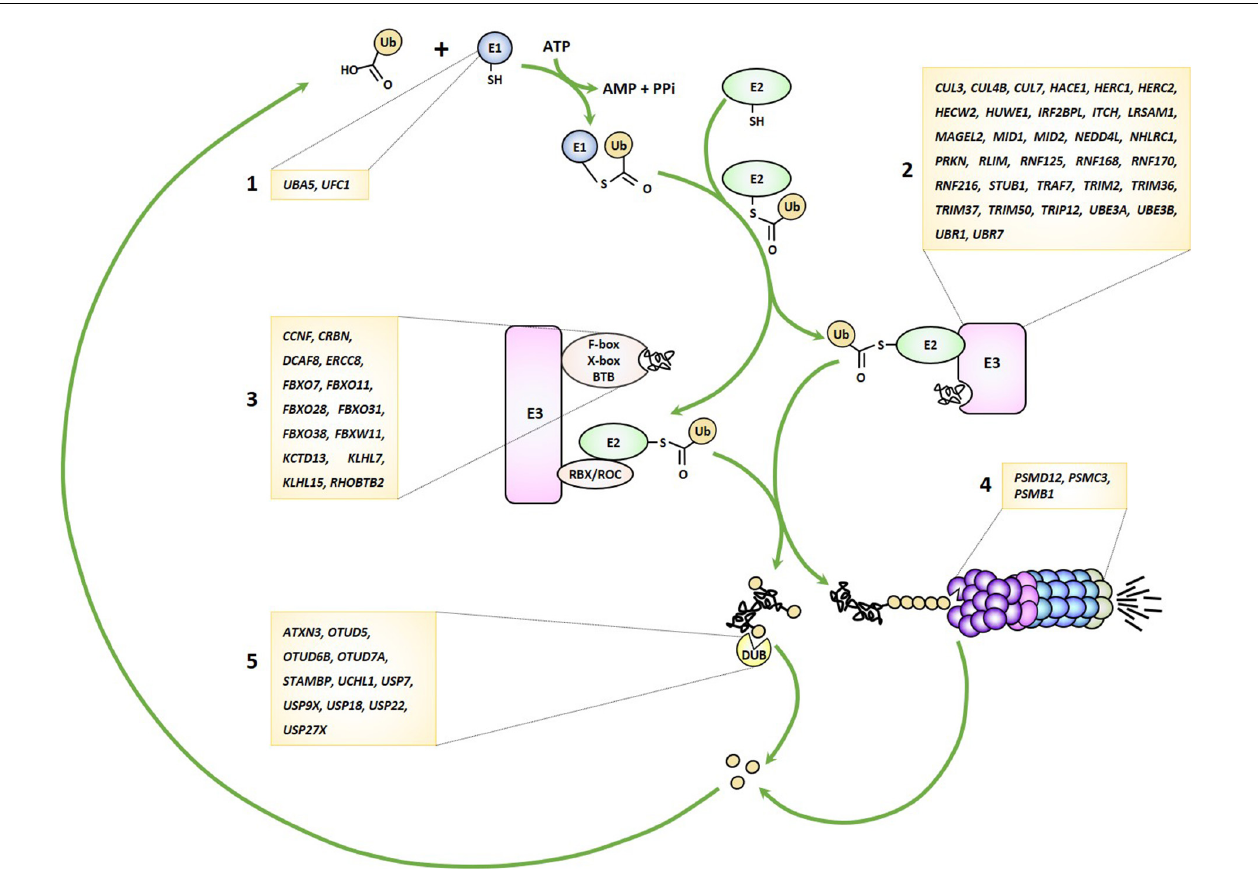
FIGURE 1 | Genetic lesions identified in patients with NDD may affect any stage of the UPS pathway. UPS-related genes disrupted in NDD encode various components of the ubiquitin-conjugation system including E1 ubiquitin-activating enzymes (1), E3 ubiquitin ligases (2), Cullin-RING-type E3 ubiquitin ligases (3), proteasome subunits (4) and deubiquitinating enzymes (5), as